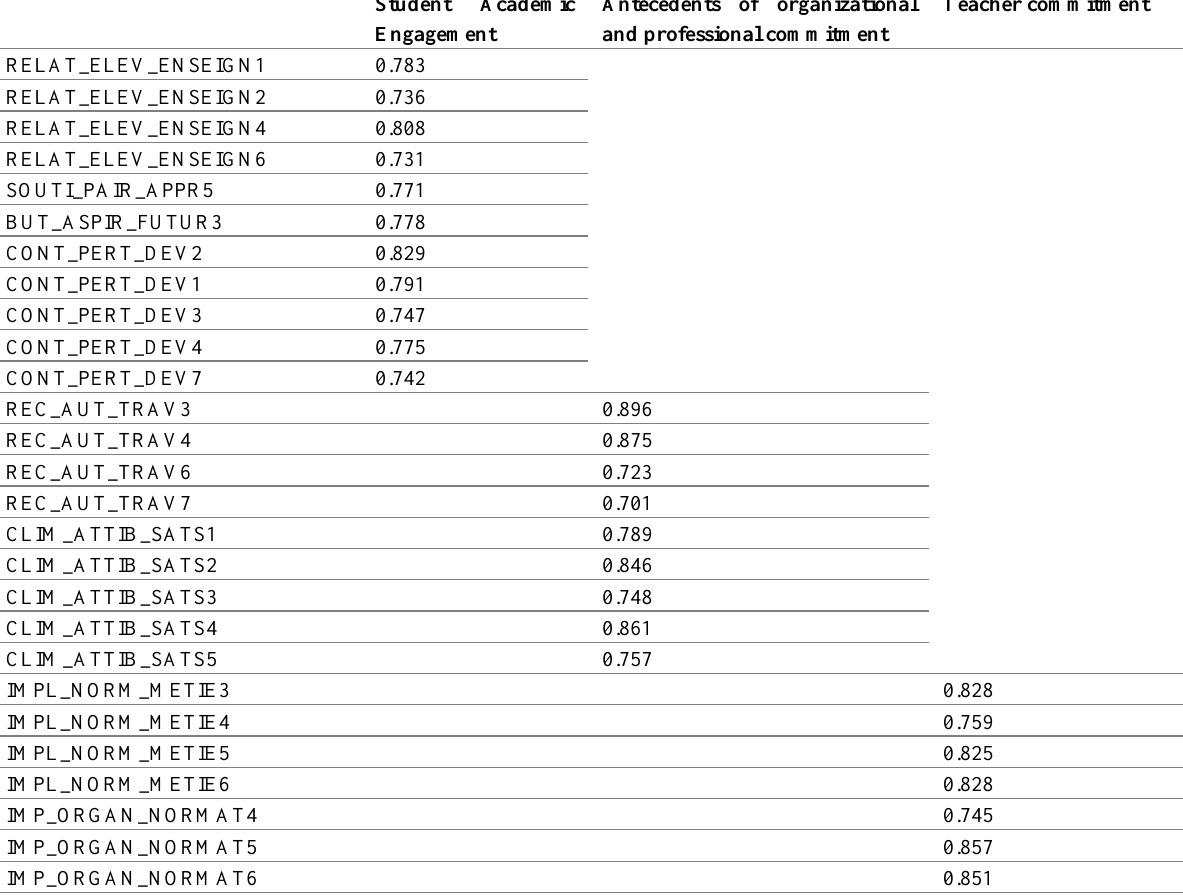
Table 7: Correlation matrix and the square root of the